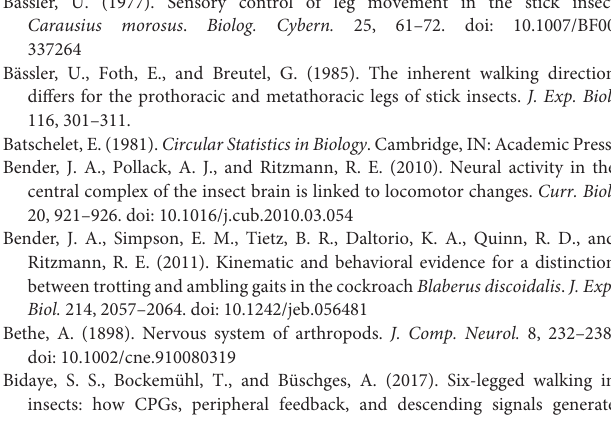
Supplementary Figure 1 | Mean and standard deviation of the frequency of movement of each leg and the movement amplitude of the midleg. The black letters indicate the frequencies of the leg movements. The red letters indicate the stroke angle of the midleg. A comparison test between intact cricket and experimental crickets was performed. A comparison test between the right and left middle leg in the experimental cricket was performed. Mann–Whitney U -test was used for the comparison test of the leg frequency and the movement amplitude. Significance level α = 0.01. (A) Intact crickets exhibited a tripod gait. (B) Disconnection of the paired circumesophageal exhibited a tripod gait. (C) Disconnection of the left-side of the circumesophageal connective exhibited a turn clockwise. (D) Disconnection of the left-side connective between the SEG and prothoracic ganglion exhibited a tripod gait. (E) Disconnection of the left-side of the circumesophageal connective and the left-side connective between the SEG and prothoracic ganglion (cutting ipsilateral side) exhibited a turn clockwise. (F) Disconnection of the left-side of the circumesophageal connective and the right-side connective between the SEG and prothoracic ganglion exhibited a